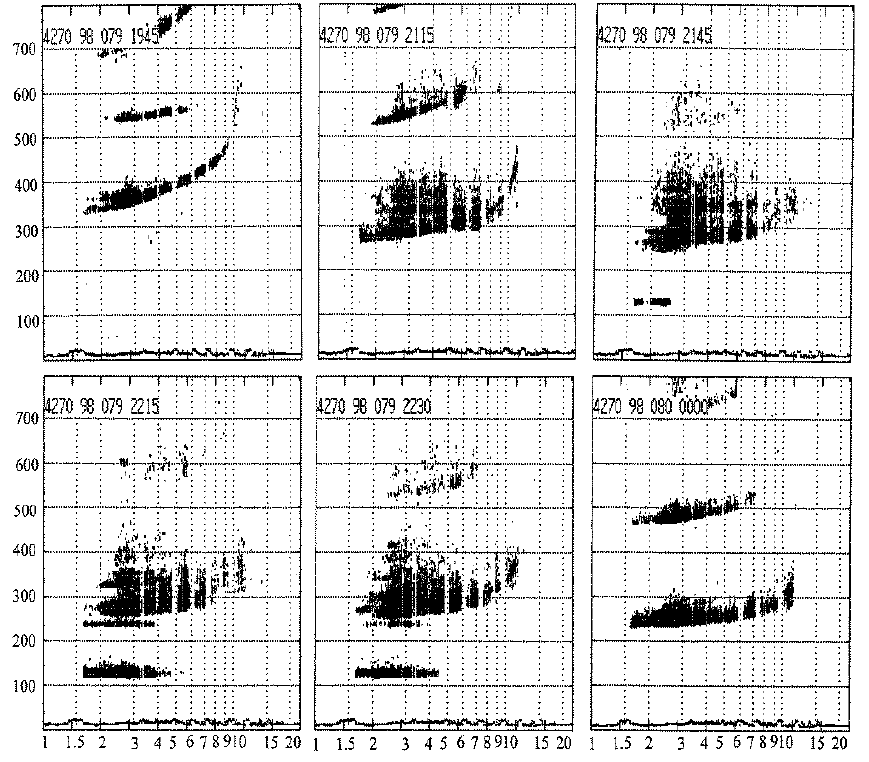
Fig. 2. Ionograms taken at SHAR (14 ◦ N, 80 ◦ E, 5.5 ◦ N dip latitude) at 19:45, 21:15, 21:45, 22:15, 22:30 and 00:00 LT on the night of 20/21 March